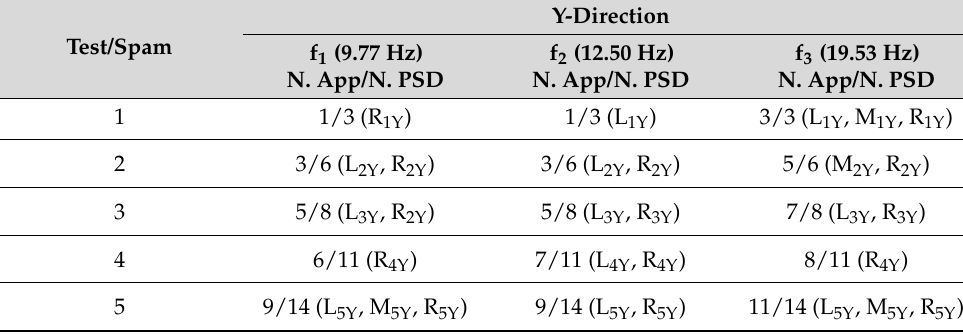
Table 5. Number of appearances varying the number of tests: